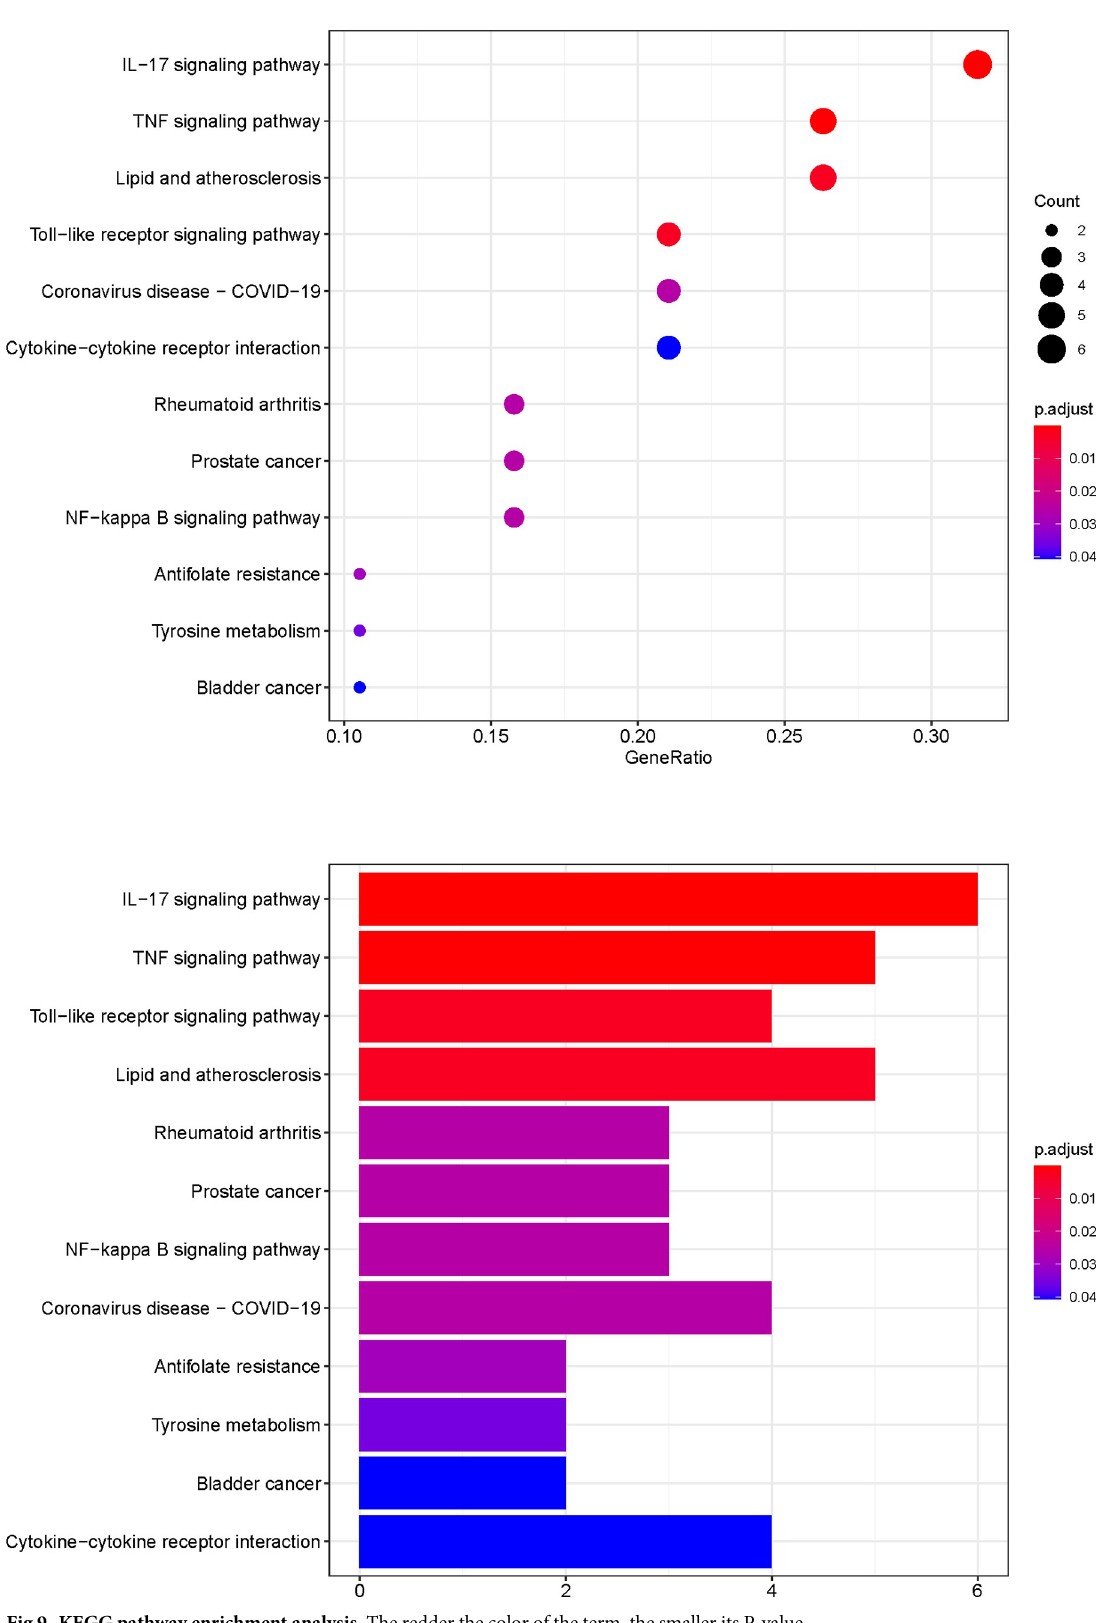
Fig 9. KEGG pathway enrichment analysis. The redder the color of the term, the smaller its P-value. https://doi.org/10.1371/journal.pone.0252508.g009 PLOS ONE | https://doi.org/10.1371/journal.pone.0252508 June 14,